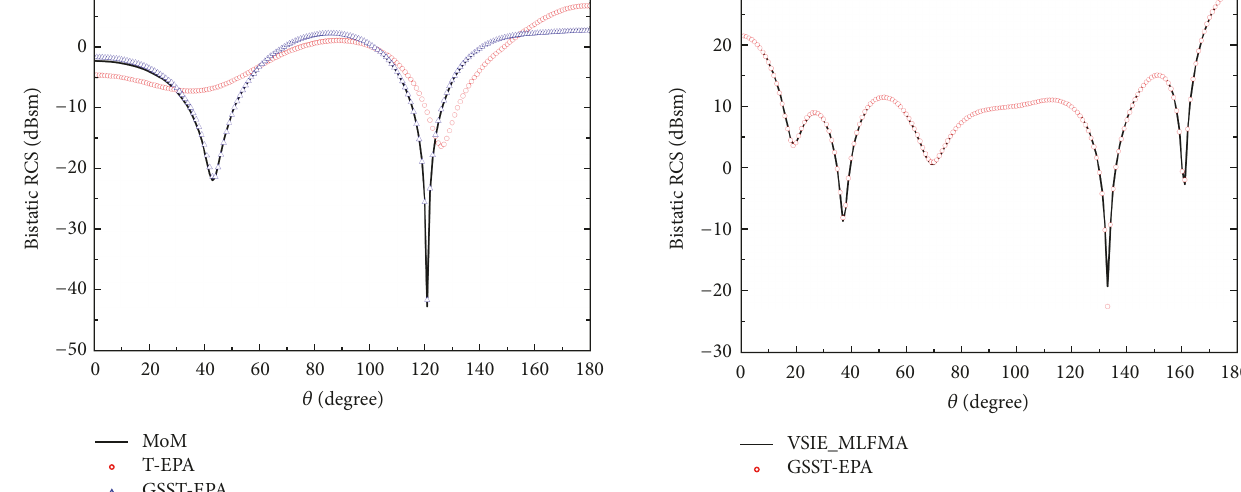
distance between two spheres is 0.605 m in ̂𝑥 and ̂𝑦 directions.